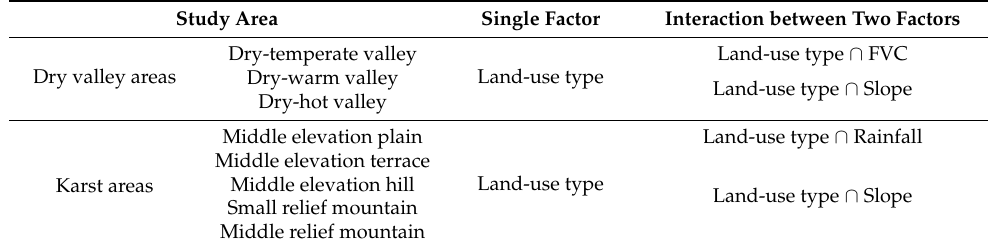
Table 7. Discrepancies among different studies that used the Geodetector